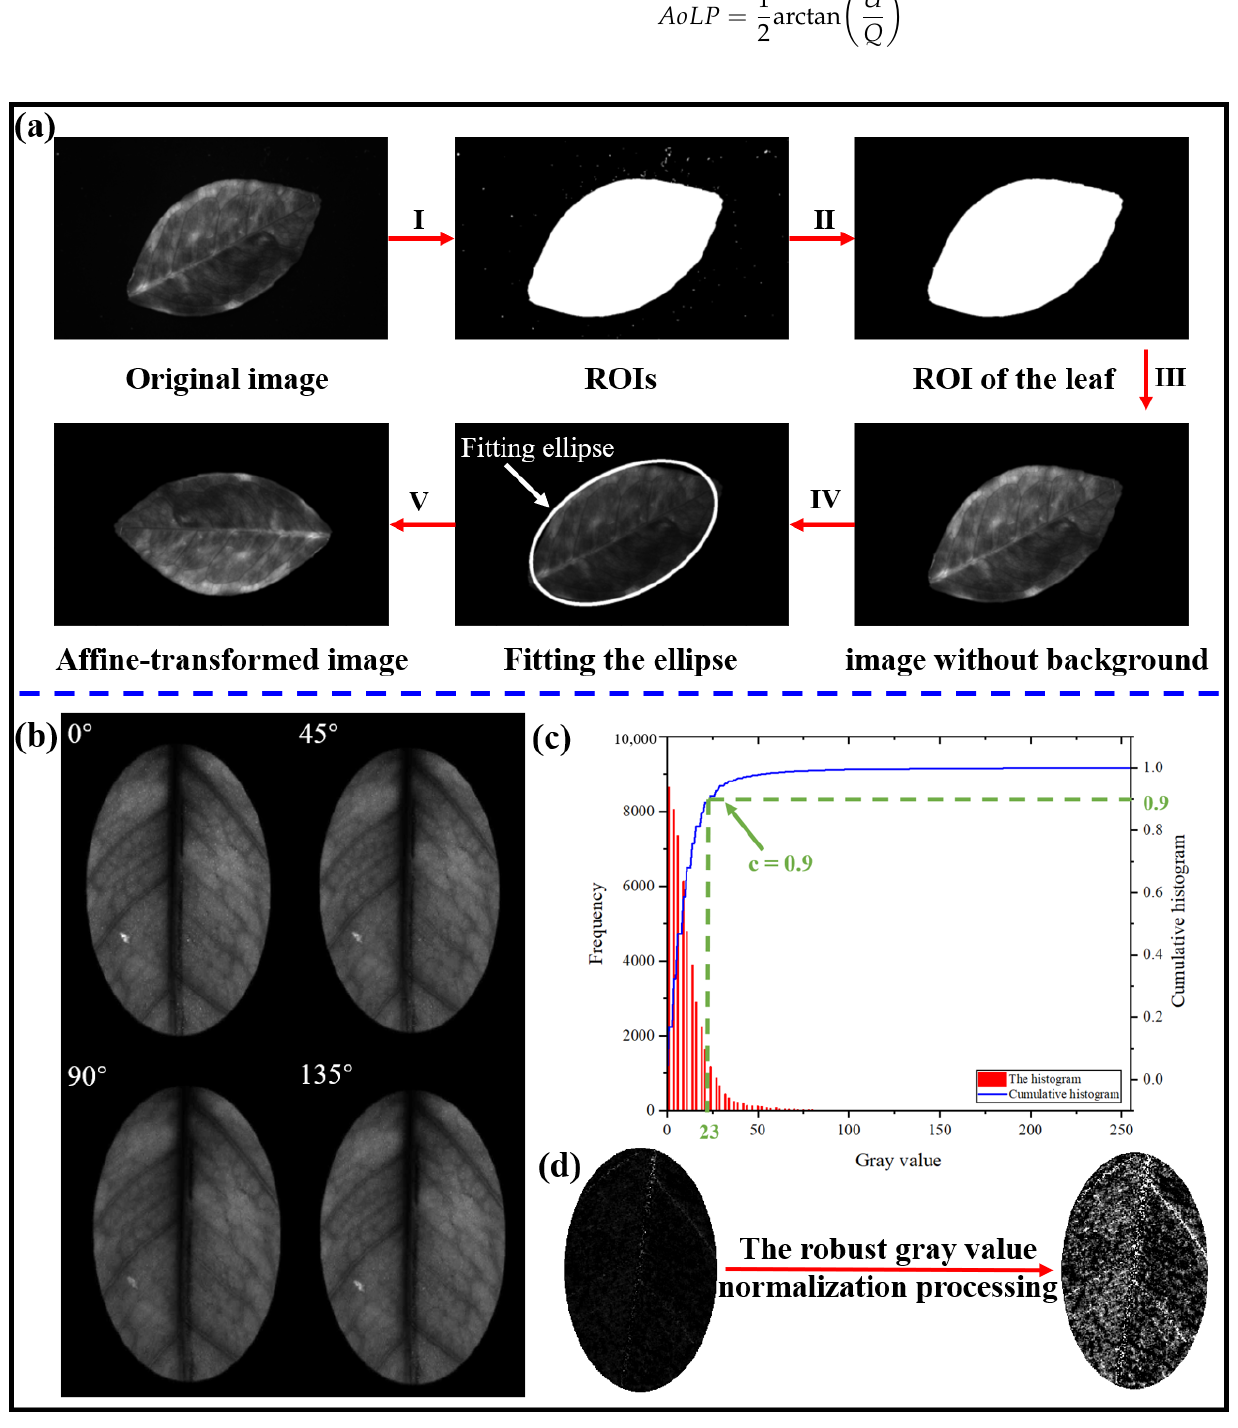
Figure 4. Pre-processing of leaf images in two imaging modes: ( a ) the pre-processing of the reflection image: (I) thresholding, (II) extraction of connected components, (III) acquiring leaf images of the region of interest (ROI), (IV) fitting the ellipse, and (V) affine transformations; ( b – d ) the pre- processing of the transmission image: ( b ) the original image obtained in transmission imaging mode, ( c ) histogram of the robust gray value normalization process, and ( d ) pre-processing result of the transmission